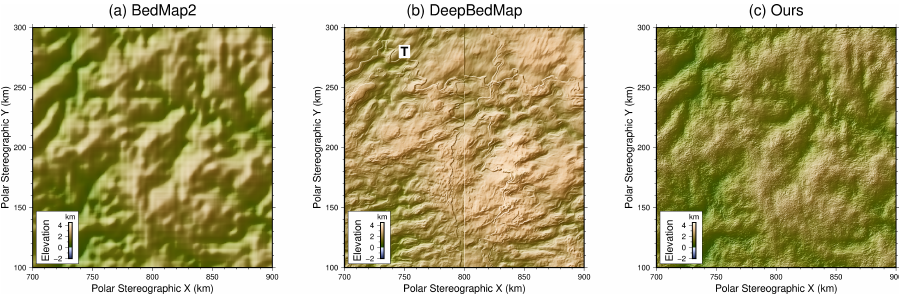
Figure 6. Bed topography comparison over the Gamburtsev Subglacial Mountains. Features of interest are annotated in black text against a white background: terraces T [17].